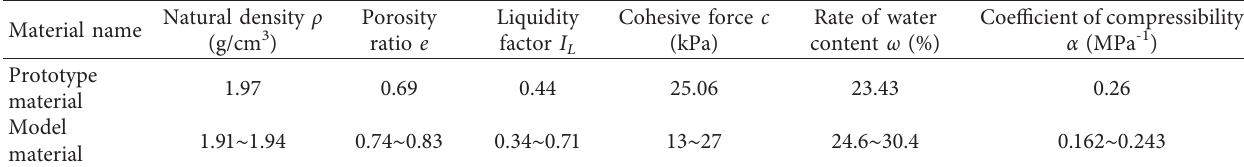
Figure 1: Test interval right line geological longitudinal section. Table 1: Physical and mechanical indexes of the model